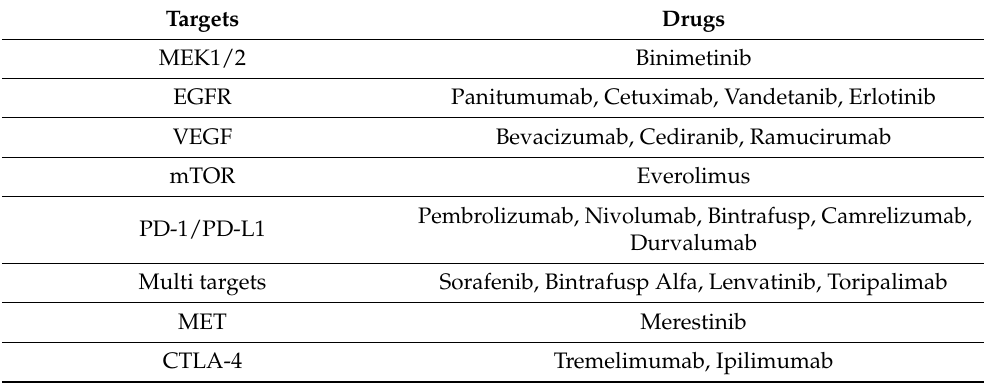
Table 1. Types of